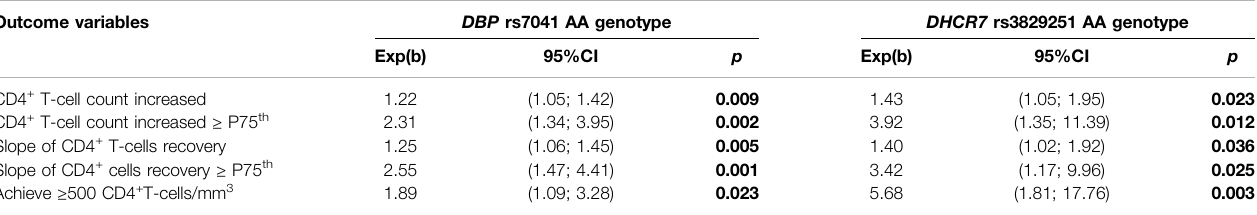
TABLE 2 | Association of DBP rs7041 and DHCR7 rs3829251 single nucleotide polymorphisms with CD4 + T-cells recovery under a recessive inheritance model in HIV- infected patients who started ART with very low CD4+T-cells count ( < 200 cells/mm 3 ). Outcome